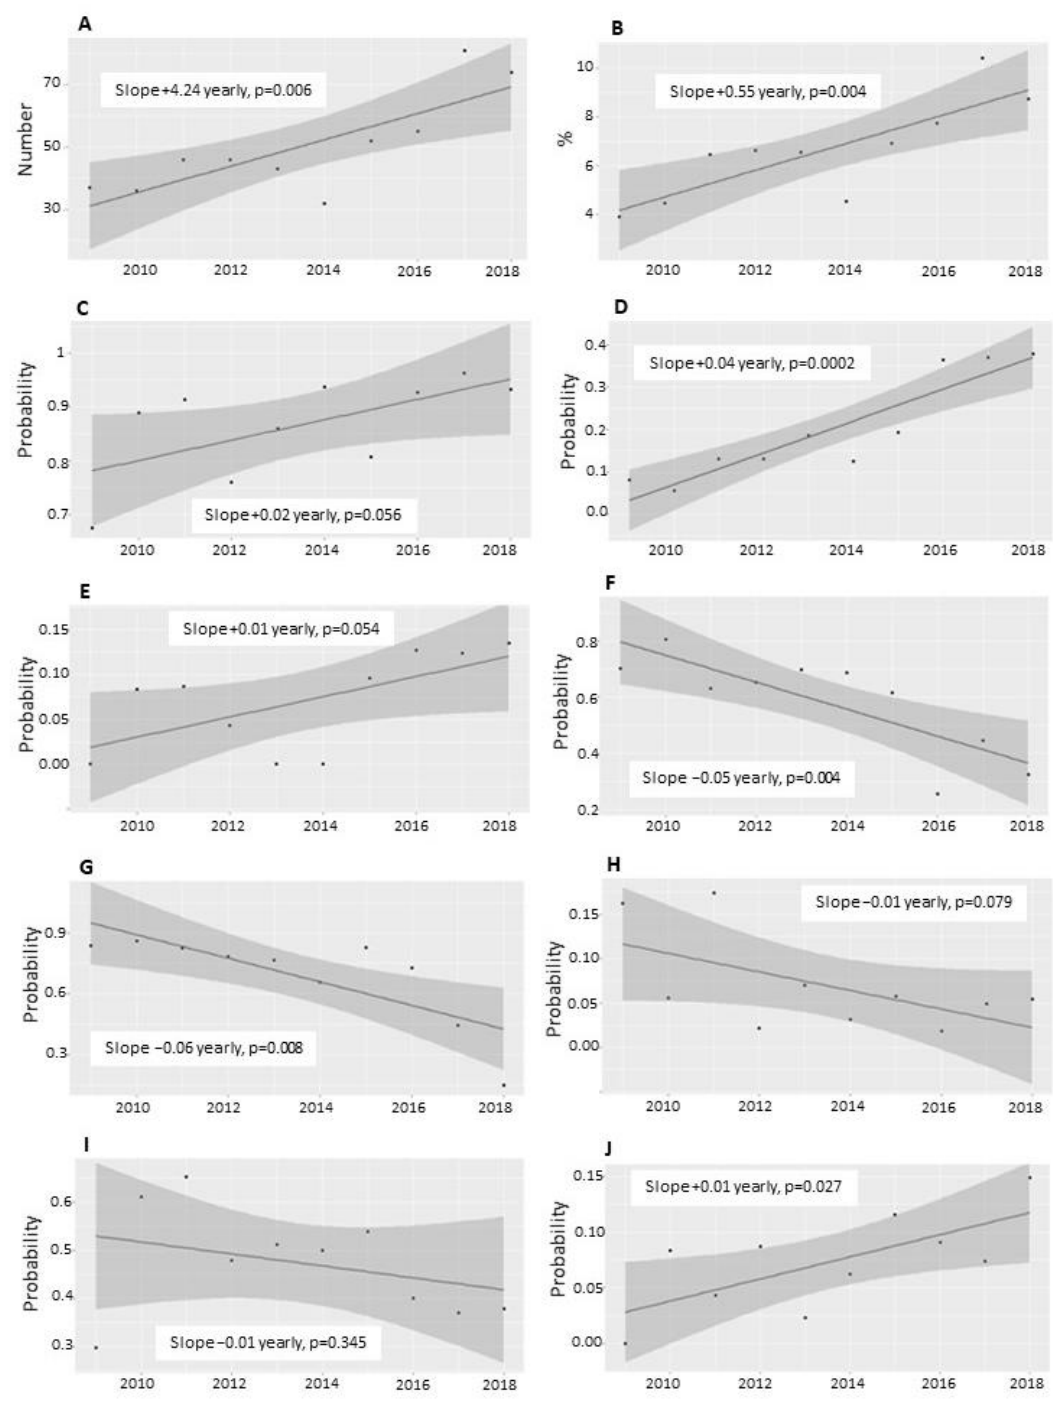
Figure 1. Incidence of RSV bronchiolitis admission, respiratory support therapies, medical treatment and evolution per year. The trend in ICU transfer in our hospital has been upward since 2009, coinciding with an increase in the number of admissions for bronchiolitis. The odds ratio (OR) of ICU transfer per year is 1.15 (95% CI: 0.991 – 1.32; p = 0.07). ( A ): Number of annual admissions for RSV bronchiolitis in the ward. ( B ): Percentage of annual admissions due to RSV bronchiolitis in the ward. ( C ): Probability of using some type of oxygen therapy. ( D ): Probability of using HFNC. ( E ): Probability of using CPAP/BLPAP. ( F ): Probability of using beta2-mimetics. ( G ): Probability of using adrenaline. ( H ): Probability of using steroids. ( I ): Probability of using fluid therapy. ( J ): Probability of ICU transfer.